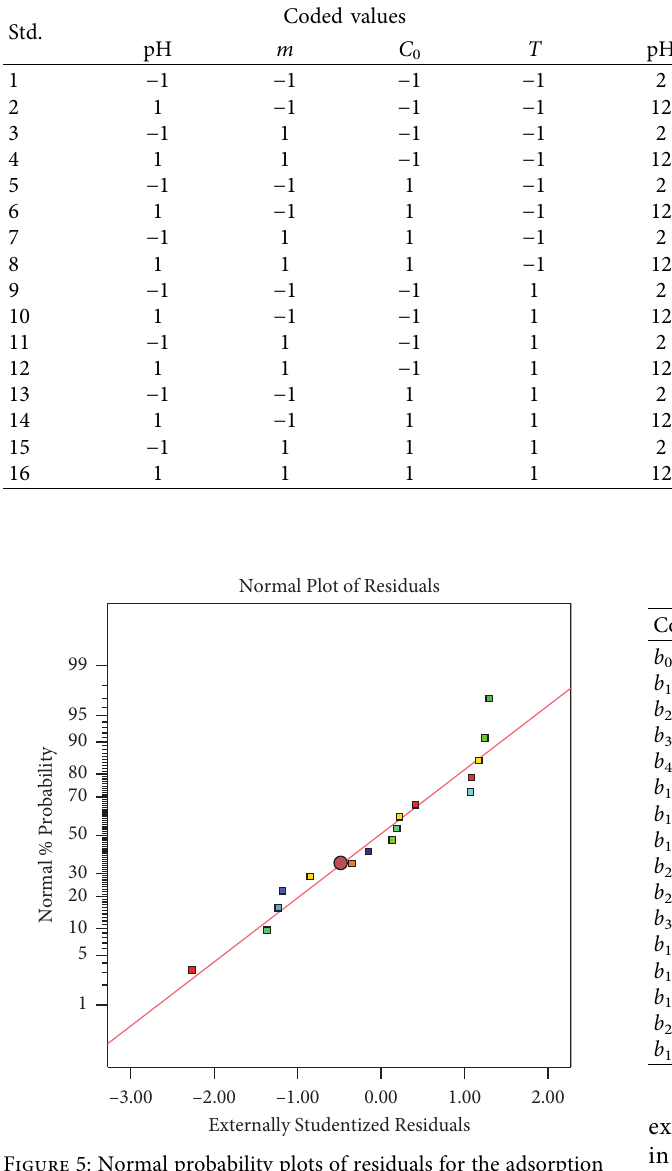
Table 8: Factorial experimental design matrix.